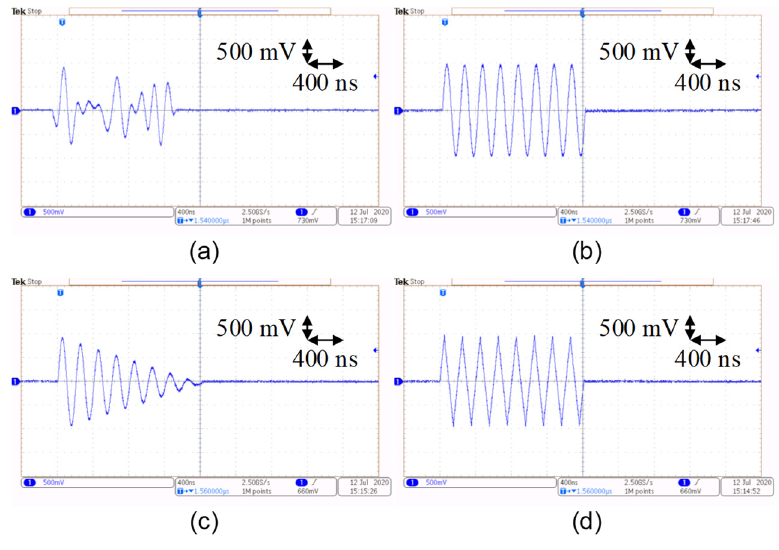
Figure 14. Input signals used for experiments. ( a ) Generated PD signal, ( b ) pure sine wave, ( c ) sine wave with linearly decaying amplitude, and ( d ) triangular wave.